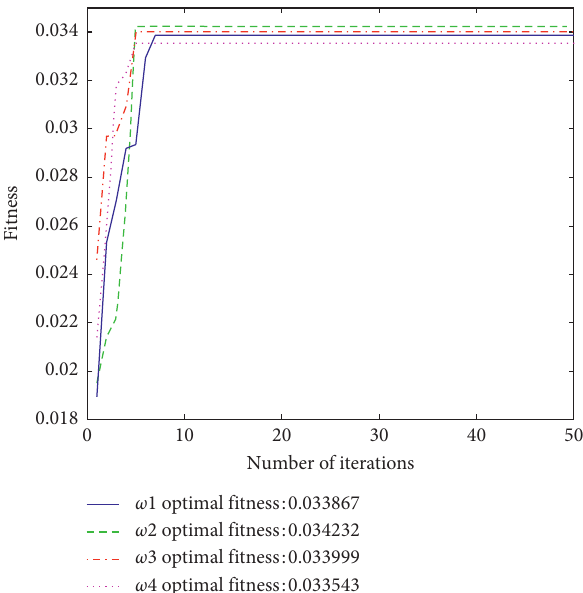
Figure 6: Fitness curves under different inertia weights.